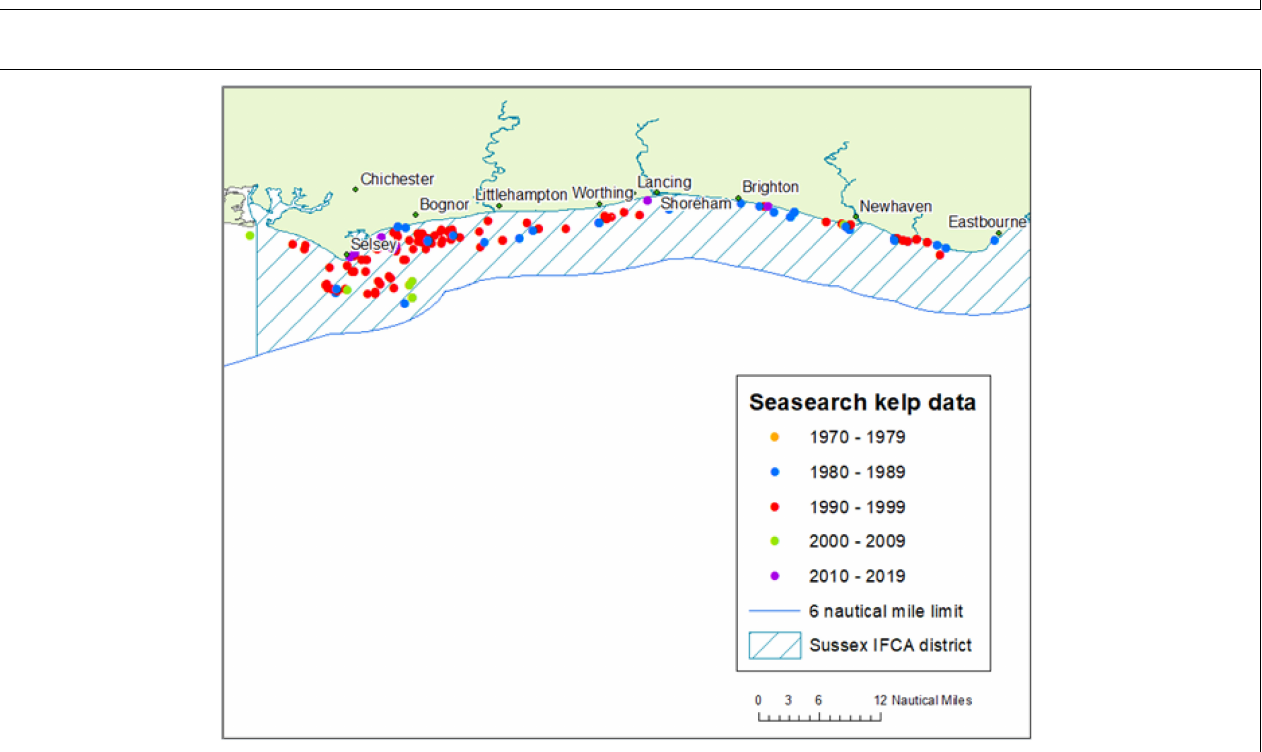
FIGURE 2 | West Sussex kelp observations point data from dive surveys (1970–2019) within the Sussex District. Source: Sussex Seasearch.